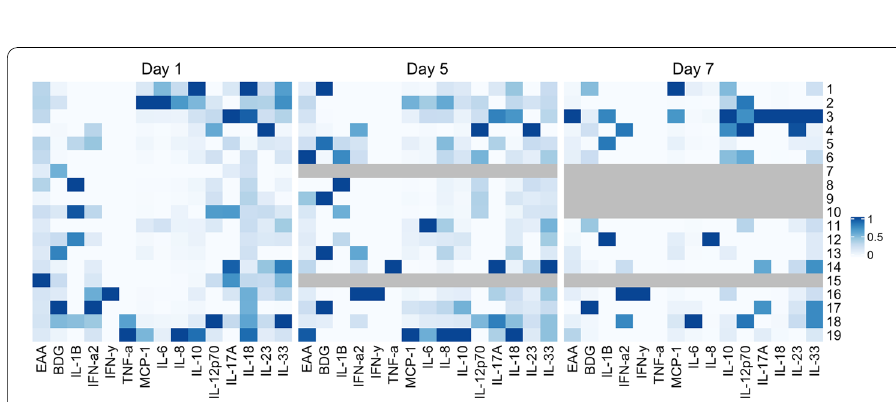
Fig. 4 Cytokine heat map on day 1, day 3, and day